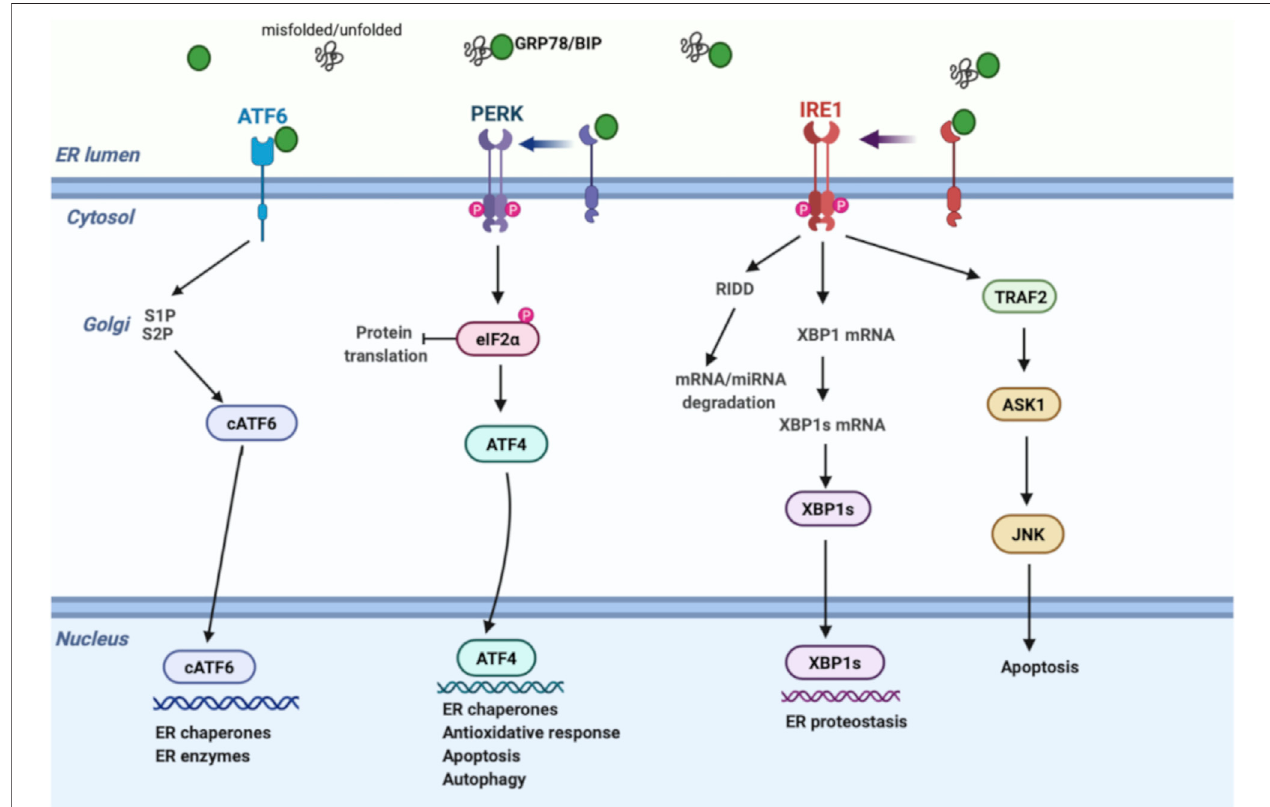
FIGURE 1 | Schematic model of UPR signalling. Under ER stress, GRP78 is released from IRE1, PERK, and ATF6, inducing three separate UPR signals; (1) PERK phosphorylates eIF2 α , inhibiting protein translation. Phospho eIF2 α enhances ATF4 expression, activating the transcription of UPR genes that regulate the antioxidative response, autophagy, and apoptosis mechanisms. (2) IRE1 induces XBP-1 splicing and RIDD pathway through RNase activity. XBP1s regulates genes involved in ER proteostasis, while RIDD modulates degradation of mRNAs and miRNAs to reduce protein burden. On the other hand, cytosolic domain of IRE1 interacts with TRAF2 to activate ASK1 and JNK, inducing apoptosis. (3) ATF6 is transported to the Golgi apparatus followed by its cleavage via proteases. Then, active cATF6 enters the nucleus and modulates ER enzymes and chaperones. ASK1, apoptosis signal-regulating kinase; ATF6, activating transcription factor 6; ATF4, activating transcription factor 4; cATF6, cleaved ATF6; eIF2 α , eukaryotic initiation factor 2 α ; GRP78, glucose-regulated protein 78; IRE1, inositol-requiring enzyme; JNK, c-Jun amino-terminalkinase;PERK,proteinkinase-likeERkinase;RIDD,regulatedIRE1-dependentdecay;S1P,site1protease;S2P,site2protease;TRAF2,tumor necrosis factor receptor-associated factor 2; UPR, unfolded protein response; XBP1, X-box binding protein 1; XBP1s, spliced x-box binding protein